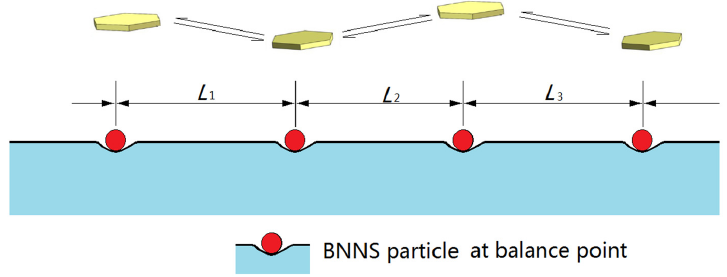
Figure 10. Schematics of stable points for the BNNSs when immersed in